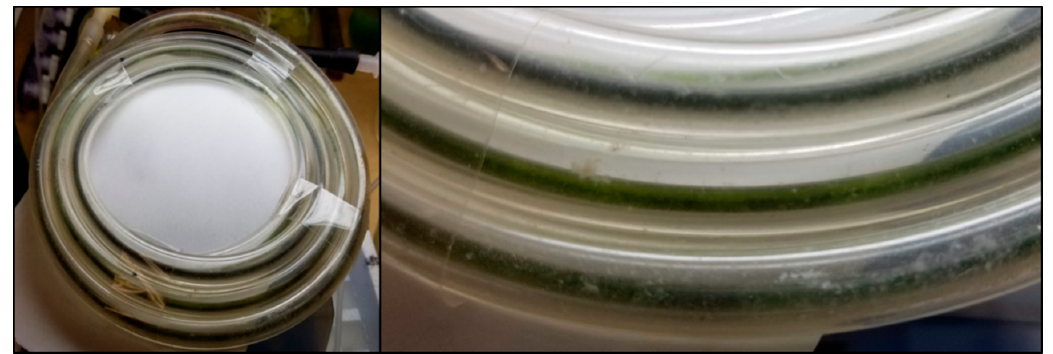
Figure 4. Image and close up of BR cons colonized by a mature photoautotrophic biofilm. Green biomass is apparent within the inner silicone tube.